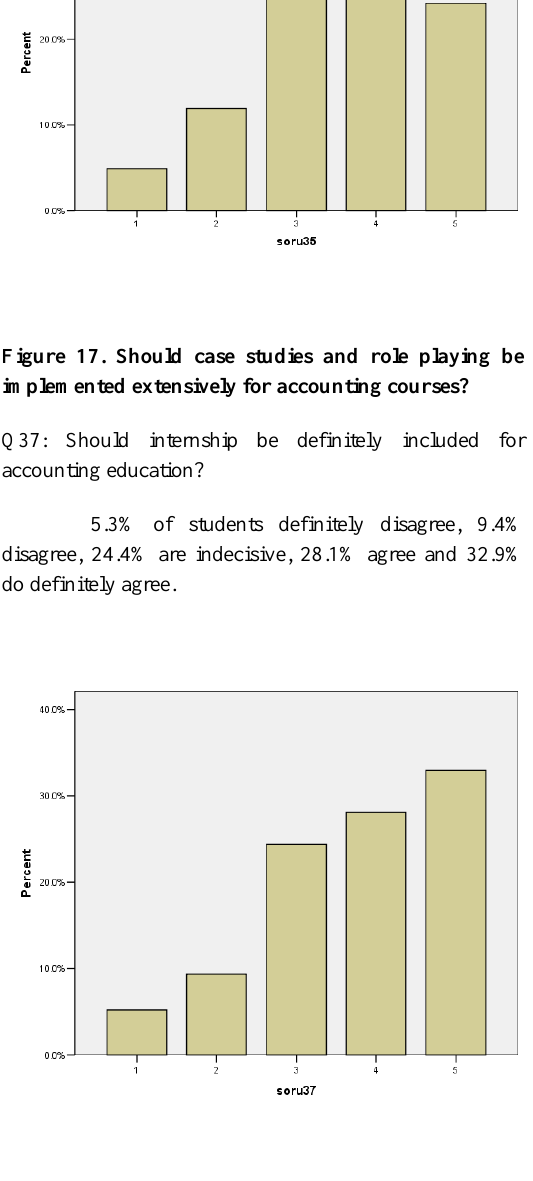
Figure 18. Should internship be definitely included for accounting